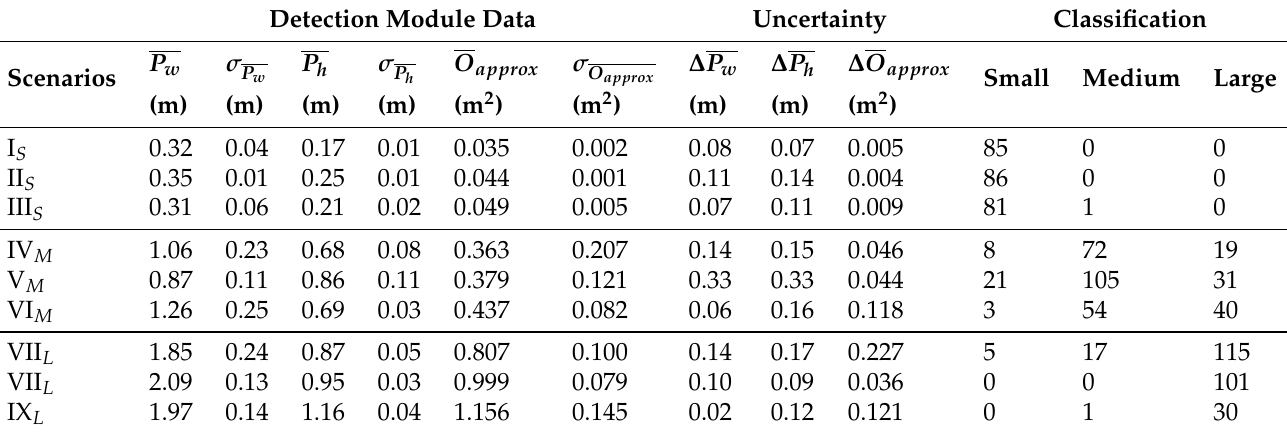
Table 6. The test results of drone size estimations, where the reference sizes can be seen in Table 3. The classification boundaries are O b 1 = 0.22 m 2 and O b 1 = 0.48 m 2